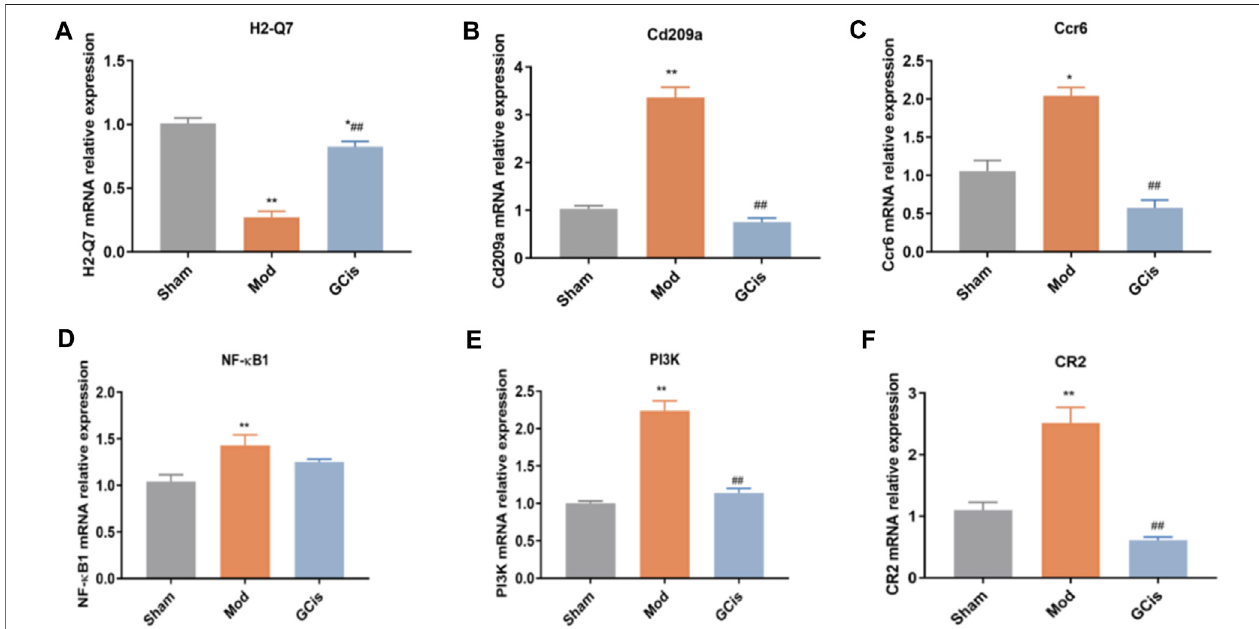
FIGURE 4 | Validation of H2-Q7 (A) , Cd209a (B) , Ccr6 (C) , NF- κ B1 (D) , PI3K (E) , and CR2 (F) . Data are shown as mean ± SEM. n = 5, * p < 0.05 and ** p < 0.01 compared with the sham group; ## p < 0.01 compared with the model